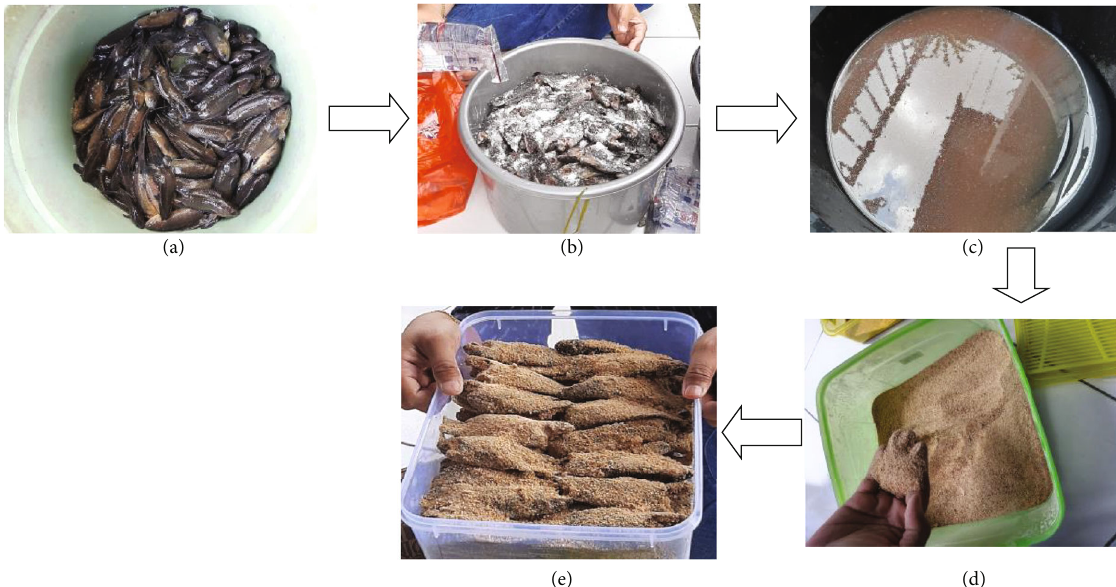
Figure 1: The process of making wadi papuyu ( Anabas testudineus Bloch.): (a) fresh papuyu ( Anabas testudineus Bloch.) fi sh used in making wadi; (b) the process of salting papuyu fi sh (left for 24 hours); (c) saltwater that comes out of the body of papuyu fi sh after being allowed to stand for 24 hours; (d) samu/lumu made from roasted-mashed rice; (e) Papuyu fi sh which was ready to be fermented into wadi for 7-14 days at room